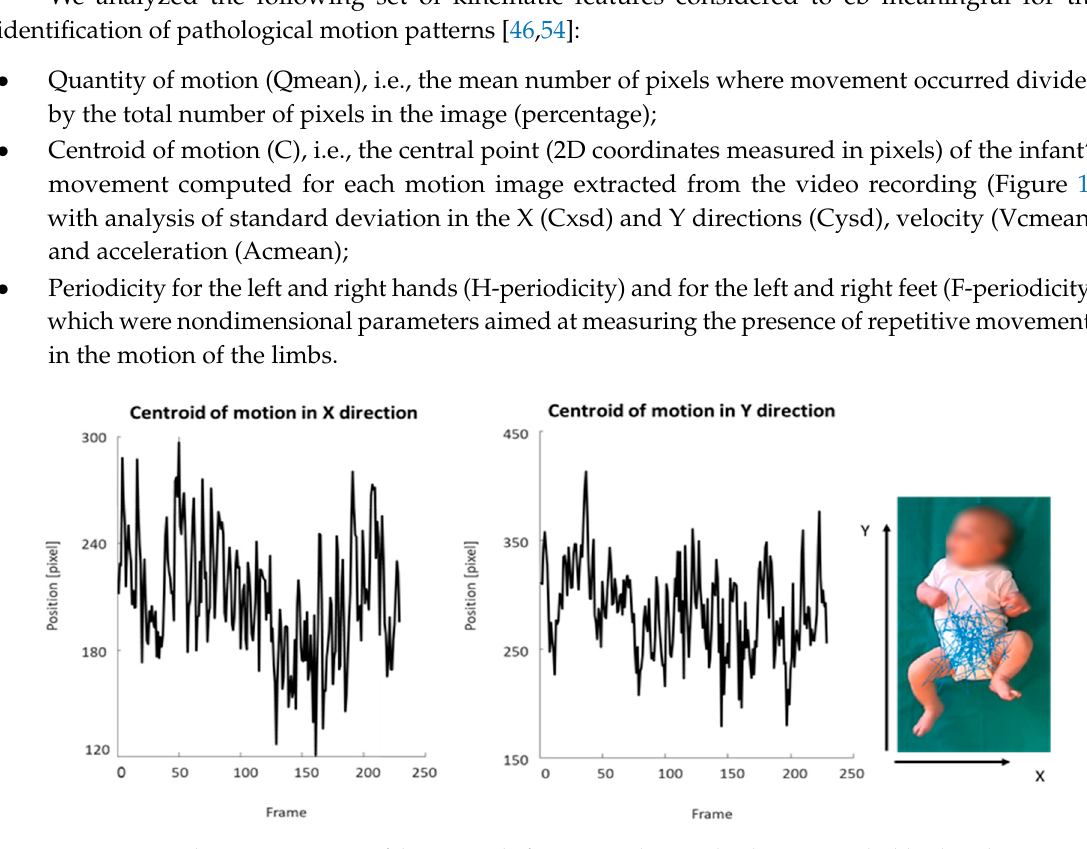
Figure 1. Graphic representation of the centroid of motion in the X and Y directions. The blue line depicts the trajectory of the centroid of motion of the infant’s movement extracted from a video